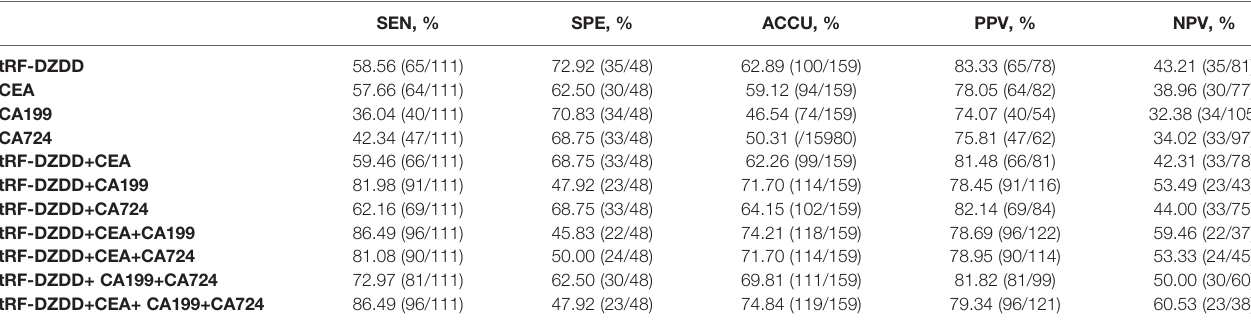
TABLE 5 | Use the expression levels of tRF-31-U5YKFN8DYDZDD, CEA, CA199, and CA724 to distinguish GC patients from gastritis patients. SEN,